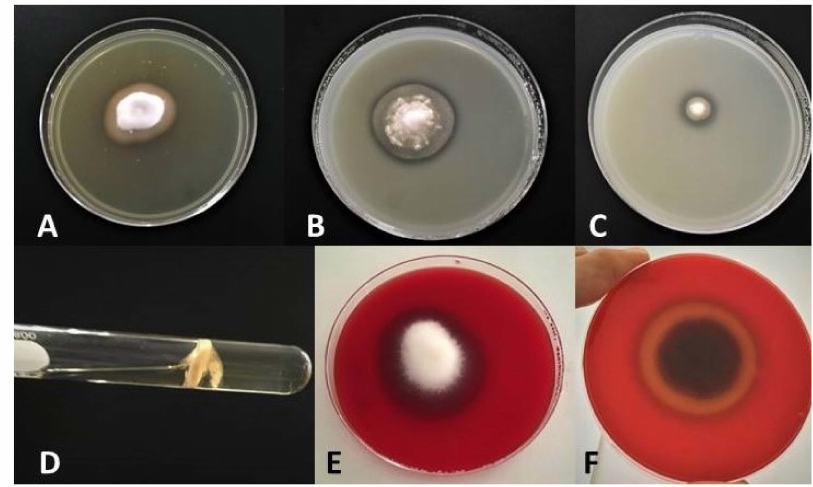
Figure 2. Production of enzymes and hemolysins by Nannizzia gypsea. ( A ) phospholipase; ( B ) Lipase; ( C ) proteinase; ( D ) gelatinase; ( E ) α -hemolysis; ( F ) β